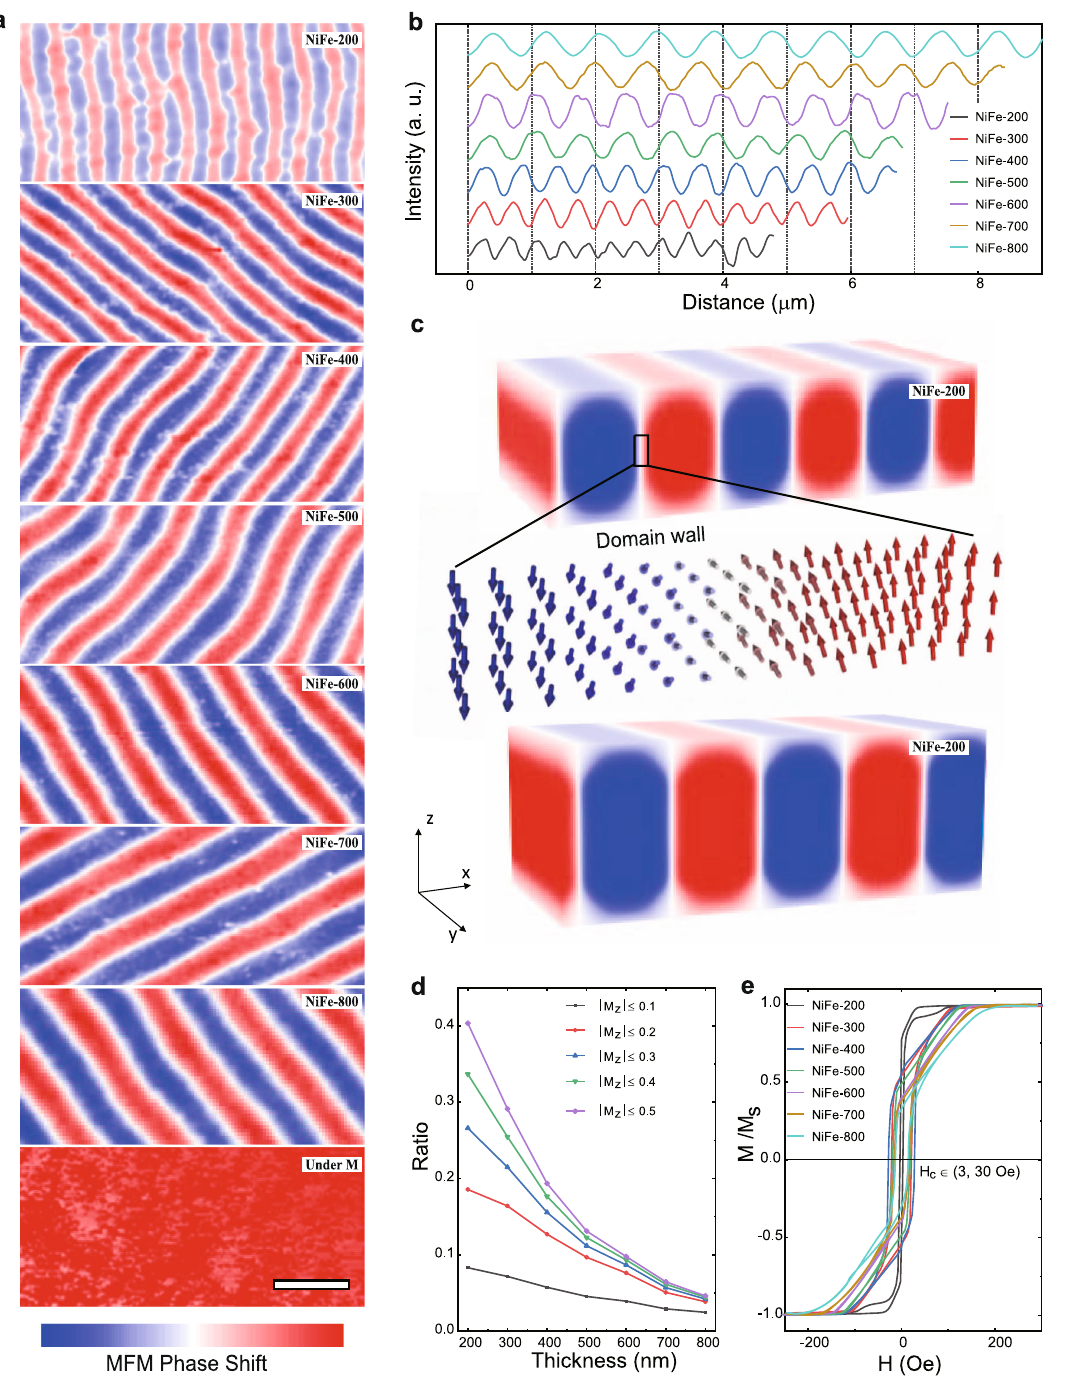
Fig.2|MagneticpropertycharacterizationsofNiFethin fi lms.a Zero- fi eldMFM NiFe-200 and NiFe-300 by micromagnetic simulations. d The proportions of domain wall in NiFe fi lms as summarized from micromagnetic simulation results. images of the magnetic domain structure of NiFe fi lms with thicknesses of 200, The M Z means the degree of deviation of magnetic distance along the z -axis 300,400, 500, 600, 700, and 800nm and a representative one (NiFe-600) forthe direction. e Experimental in-plane hysteresis loops for different NiFe fi lm magnetized fi lms under an in-plane magnetic fi eld of 2000 Oe. The scale bar of those images is 1 μ m. b The phase line pro fi les acquired from MFM images of NiFe fi lms. c Distributions of the M z magnetization component over stripe domains of